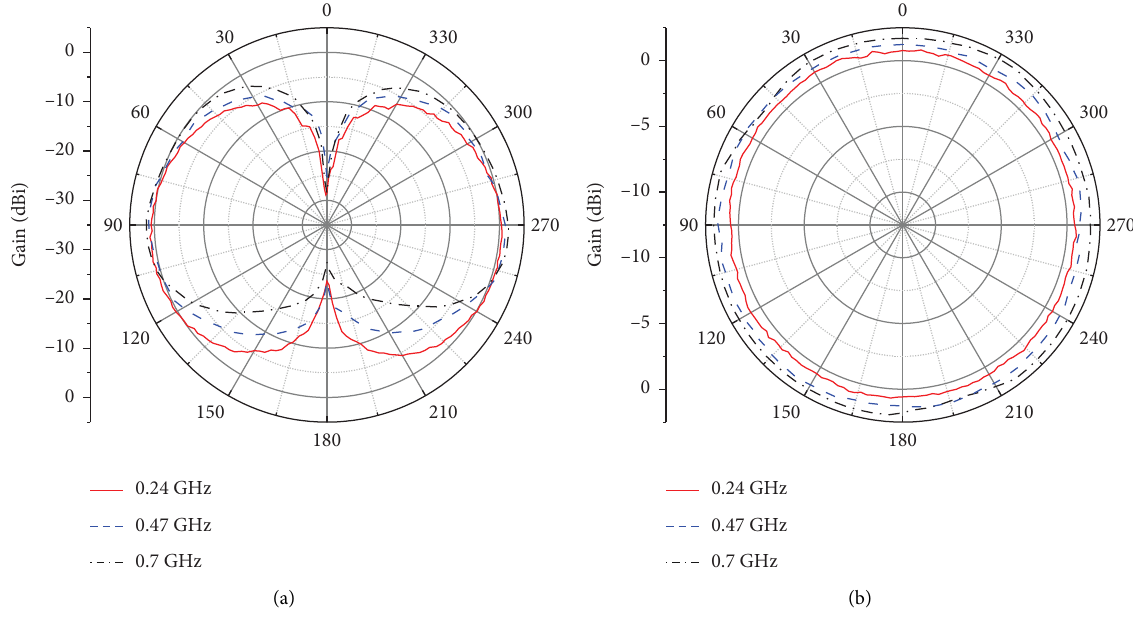
Figure 8: Radiation pattern of the proposed antenna at the lower band: (a) E-plane and (b) H-plane.